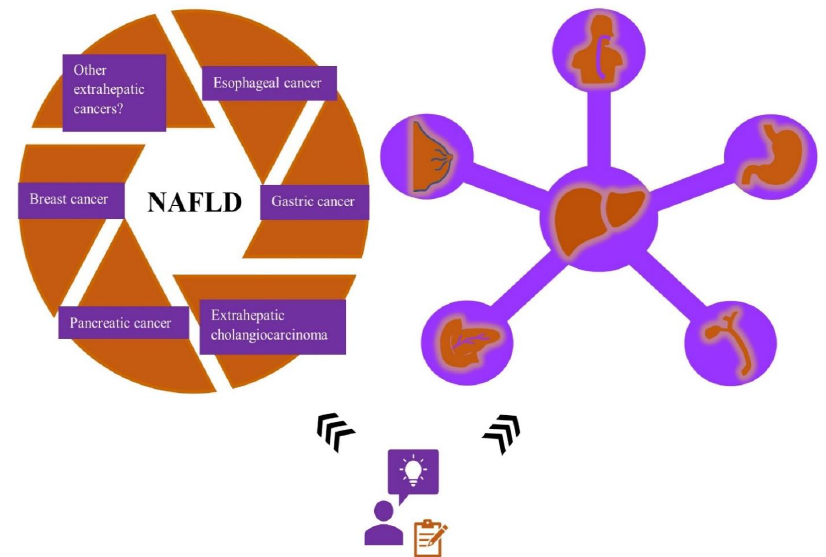
Figure 4. The association between NAFLD and the risk of developing other extrahepatic malignancies besides colorectal cancer remains a subject of ongoing research. Recent studies suggest that NAFLD and metabolic syndrome might be closely related to an increased cancer risk. NAFLD — non-alcoholic fatty liver disease. Esophageal cancer, the 8th most common malignancy globally, is considered to be strongly associated with obesity [11]. In fact, obesity represents a significant risk factor for developing esophageal cancer by increasing the risk up to approximately four-fold com- pared with lean individuals [11,218]. Several studies support that central adiposity, inde- pendent of BMI, is associated with the development of Barrett ’ s esophagus (BE) and esophageal adenocarcinoma (EAC), eventually contributing to the progression from in- flammation to metaplasia (BE) and neoplasia (EAC) [219]. According to other researchers, their results showed a significant dose-dependent correlation between BMI and the risk of developing EAC [218]. Subjects with higher waist circumferences, independent of BMI, were found to be at a 1.5 – 2.8-fold increased risk of developing BE among both males and females [220]. Similarly, other studies also suggest that visceral abdominal fat could rep- resent a significant risk factor for the development of BE [221].